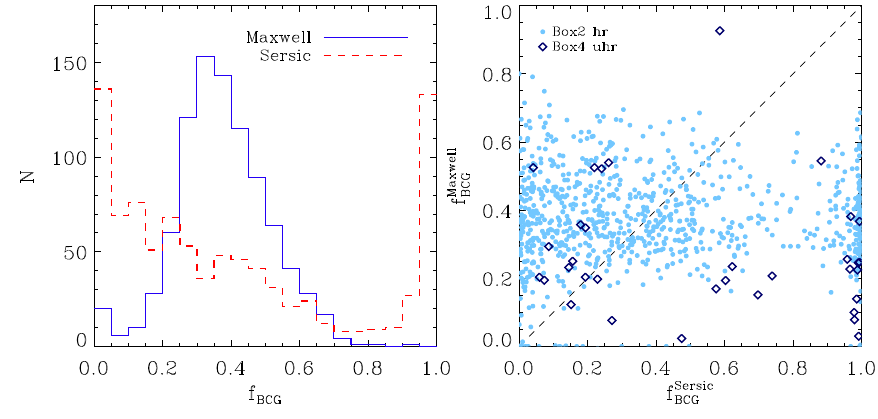
Figure 6. Left panel: Histogram of the mass fraction ascribed to the BCG according to the double-Maxwell fits (blue) and the double-Sérsic fits (red). The mass ascribed to the BCG is always the mass of the slower (Maxwellian fits) or the innermost (Sérsic fits) component. Right panel: BCG mass fractions obtained from the Maxwell fits versus those obtained with the Sérsic fits. Light blue symbols show the clusters from Box2b, while dark blue open diamonds mark the galaxy groups selected from Box4. There is no evident correlation between the mass partitioning obtained with the two different methods, and there is also no difference between galaxy groups and